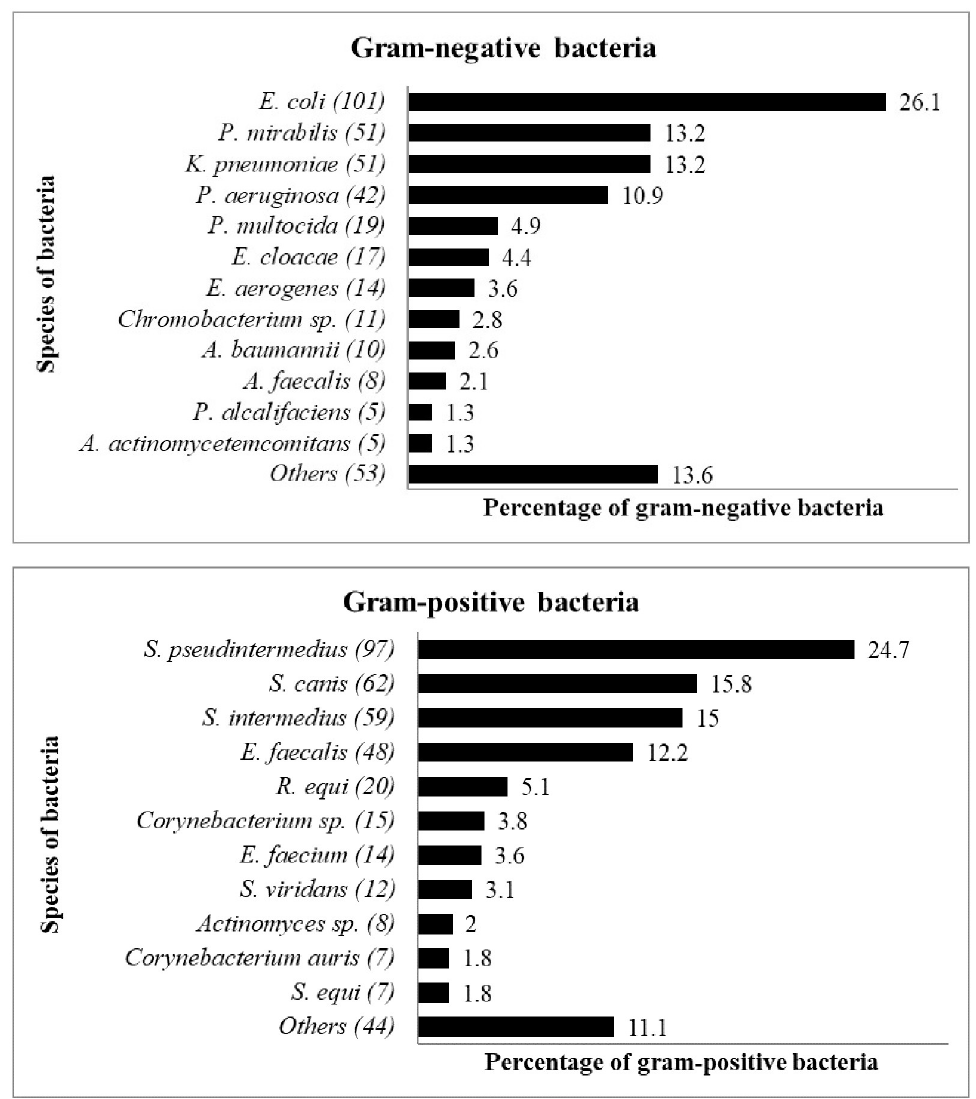
Fig 1. The distribution of bacterial species (Gram-negative and gram-positive bacteria) from diseased pets isolated between January 2015 and December 2017. Numbers inside brackets ‘()’ indicate the total number of bacterial